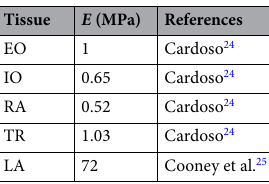
Table 1. Values of Young’s modulus ( E ) assumed in the present study for the different tissues in our AW model.